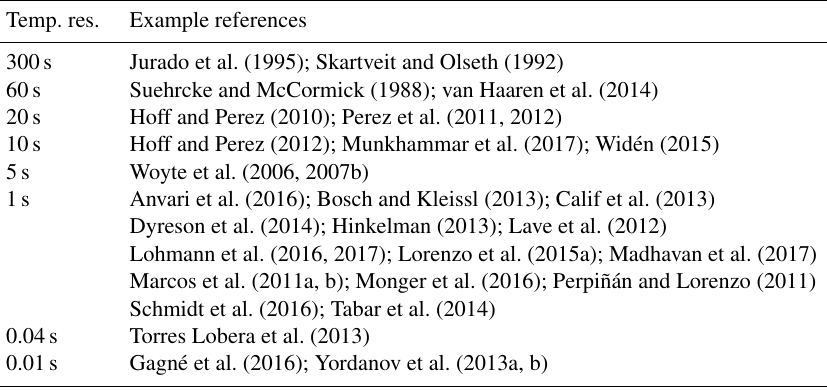
Table 1. Previous studies of short-term irradiance variability and the temporal resolutions considered. Temp.